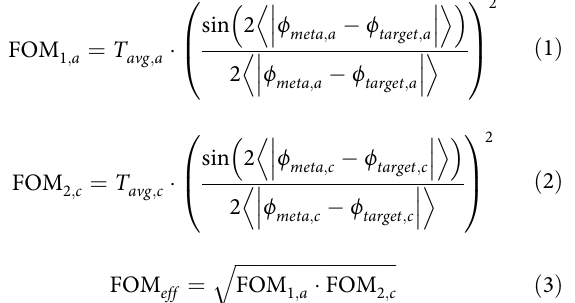
hyperbolic phase pro fi les (with 2 π phase wraps) yielding focal lengths of f 1 = 1.5 mm (amorphous, a-state) and f 2 = 2 mm (crystalline, c-state) are plotted in Figs. 2a and 2f, respectively.